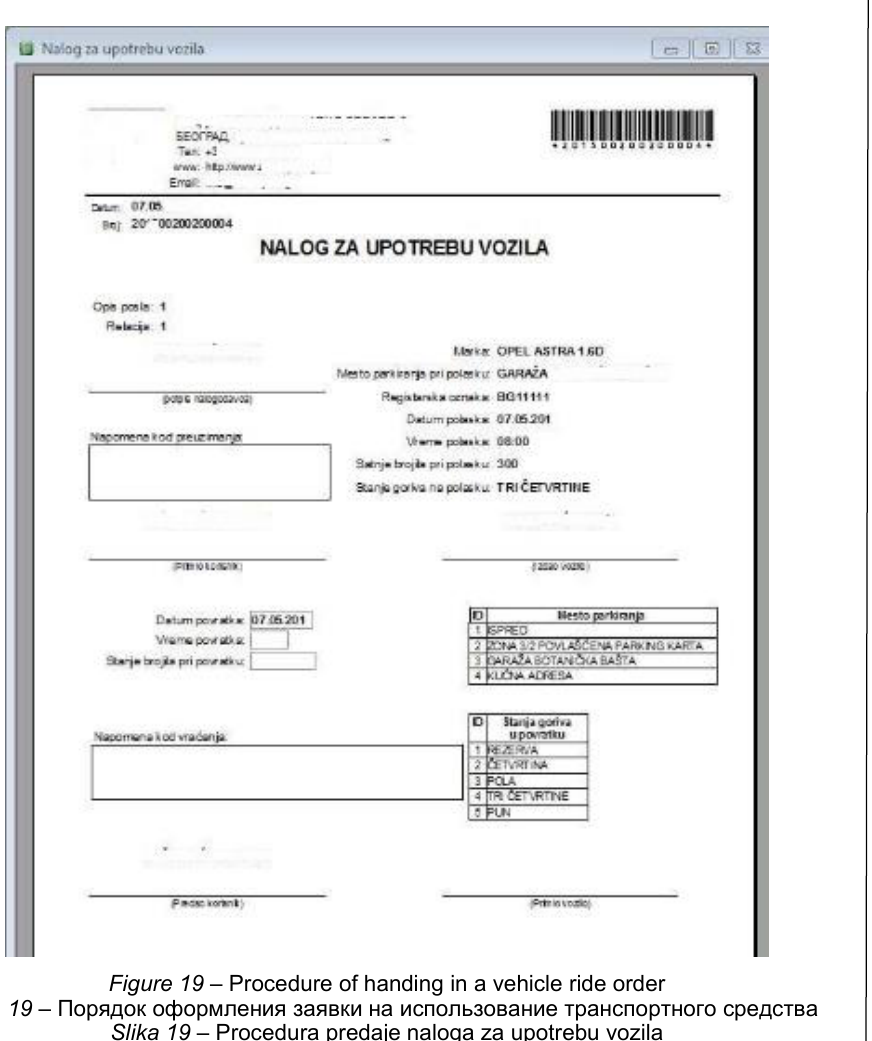
Figure 19 – Procedure of handing in a vehicle ride order Рис . 19 – Порядок оформления заявки на использование транспортного